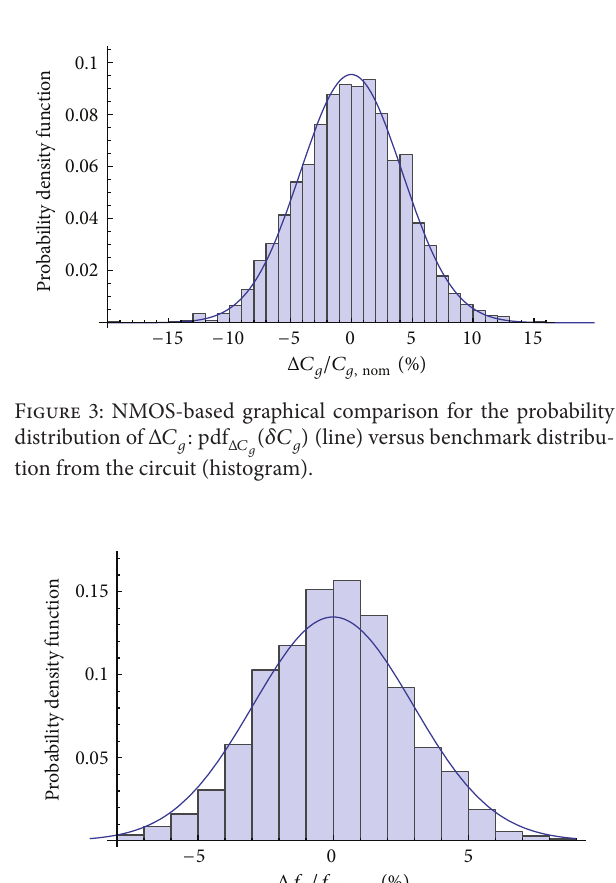
(𝛿𝑓 ) (line) versus benchmark distribu- 𝑇 𝑇